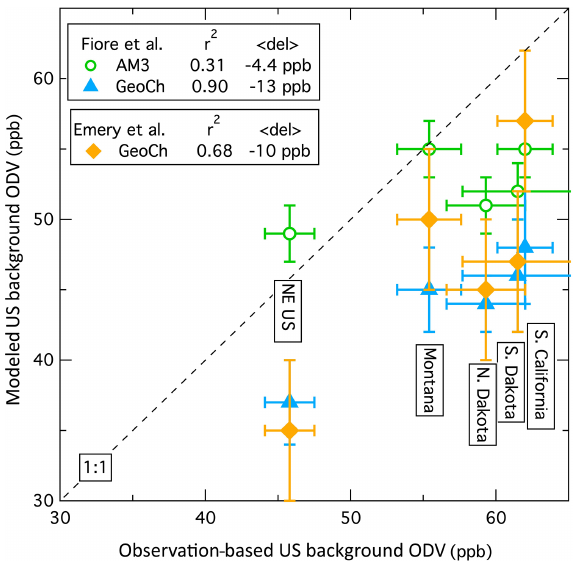
Figure 14. Comparison of US background ODV estimates from model calculations with those derived in this work from observa- tions. The r 2 values of the correlations and the average differences (<del>) are